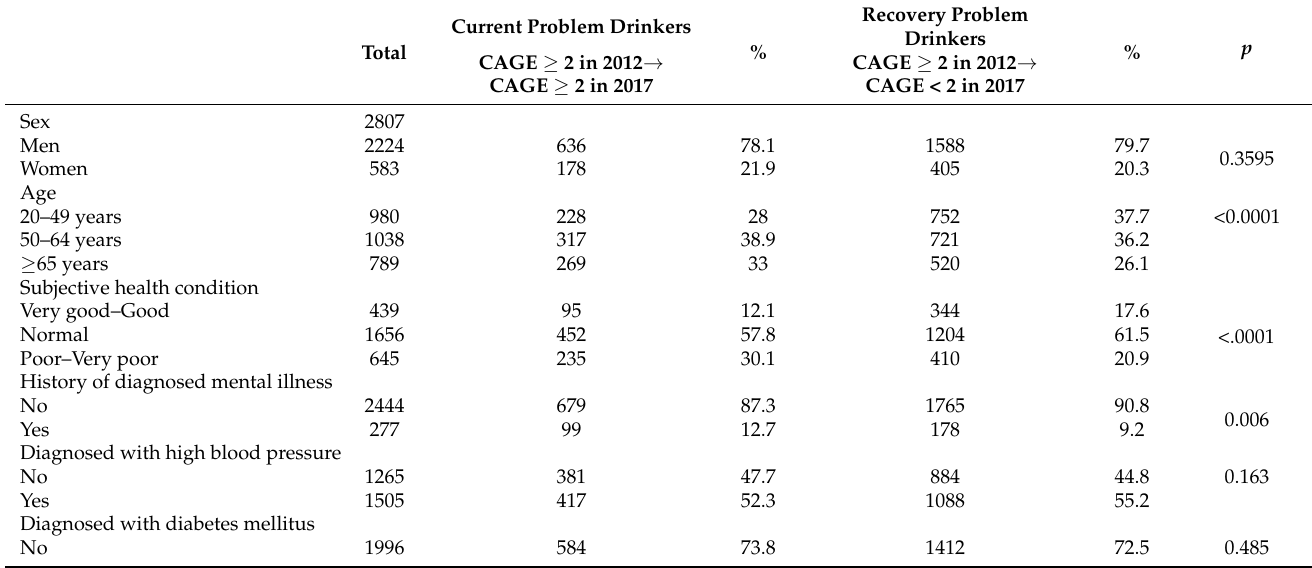
Table 4. Characteristics of problem drinkers in FY 2012 by subsequent